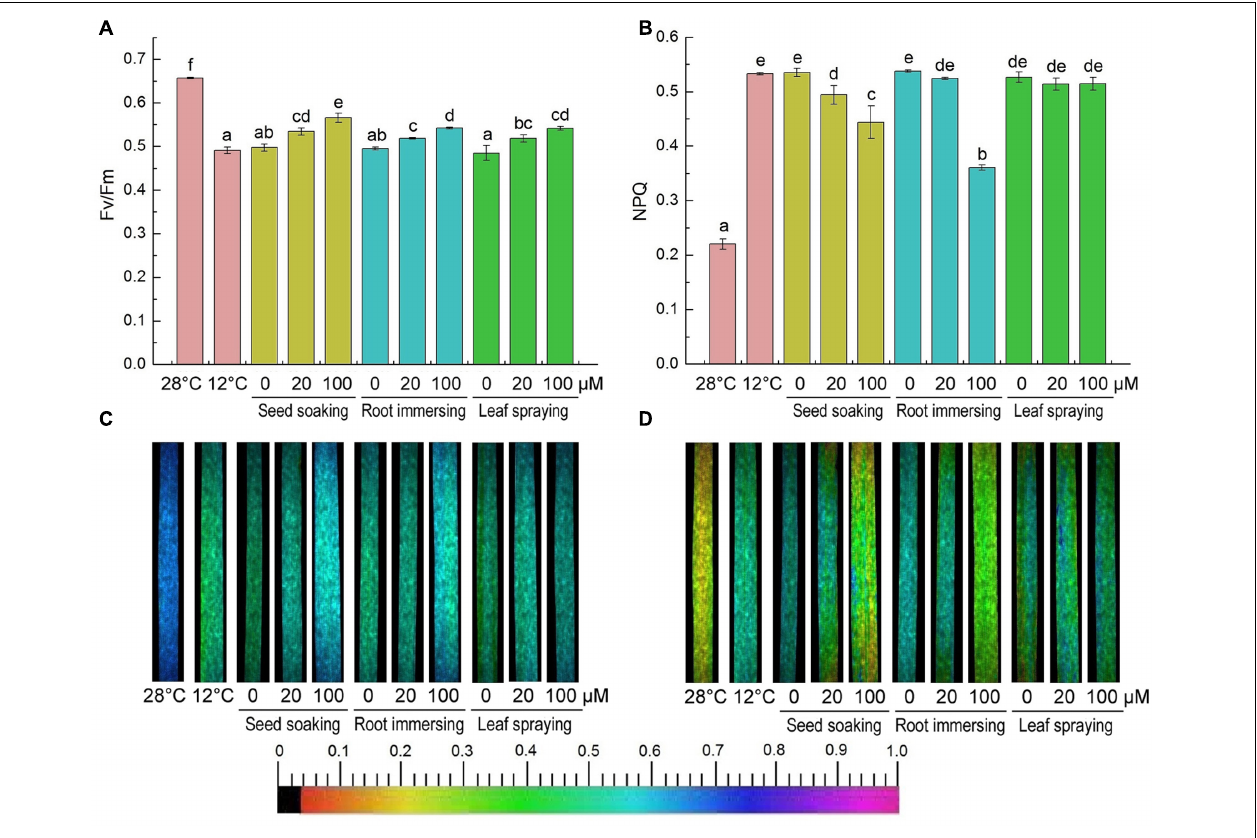
FIGURE 7 | Effects of exogenous melatonin on maximum PSII quantum yield (Fv/Fm) (A,C) , and non-photochemical quenching (NPQ) (B,D) after 6-day cold stress (12 ◦ C). Quantitative values (A,B) and fluorescence image (C,D) . Others are the same as in Figure 1